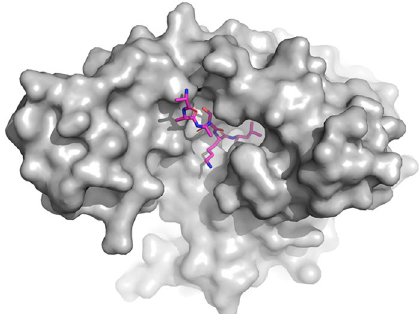
Figure 1. PTS1 binding pocket of PEX5 as a potential target for inhibitor development. Surface representation of Trypanosoma brucei PEX5 (grey) in complex with PTS1 (magenta sticks) (PDB code: 3CVP). Structure of T. cruzi PEX5 is not available, but high sequence identity of T. cruzi and T. brucei Pex5 allows to expect similar binding